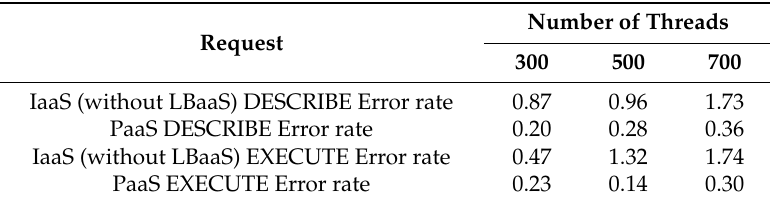
Table 4. Error rate of two operations in